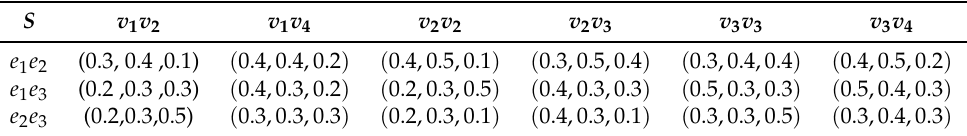
Table 8. Neutrosophic soft relation S .